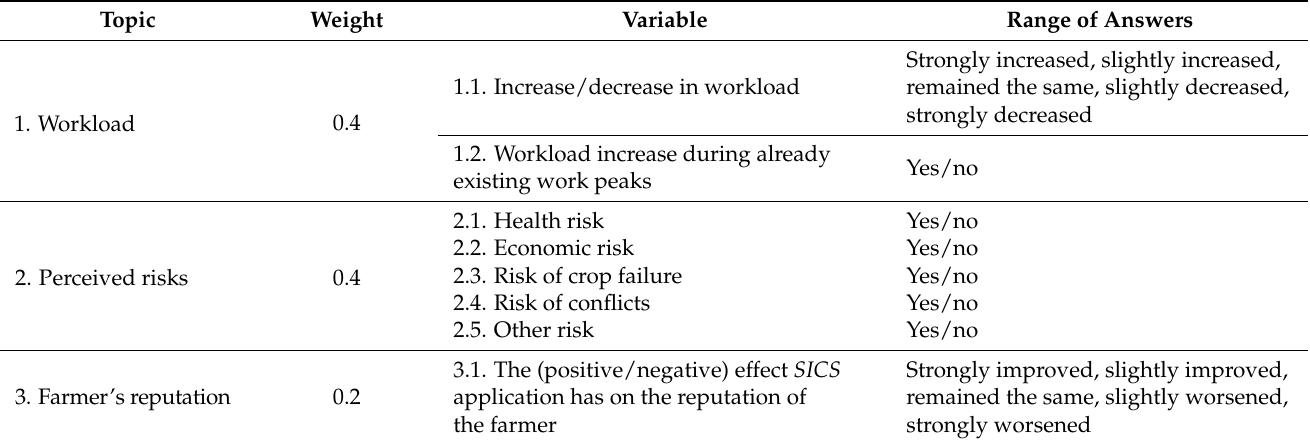
Table 2. Variables considered in the sociocultural dimension based on a questionnaire completed by the land user and their weighing